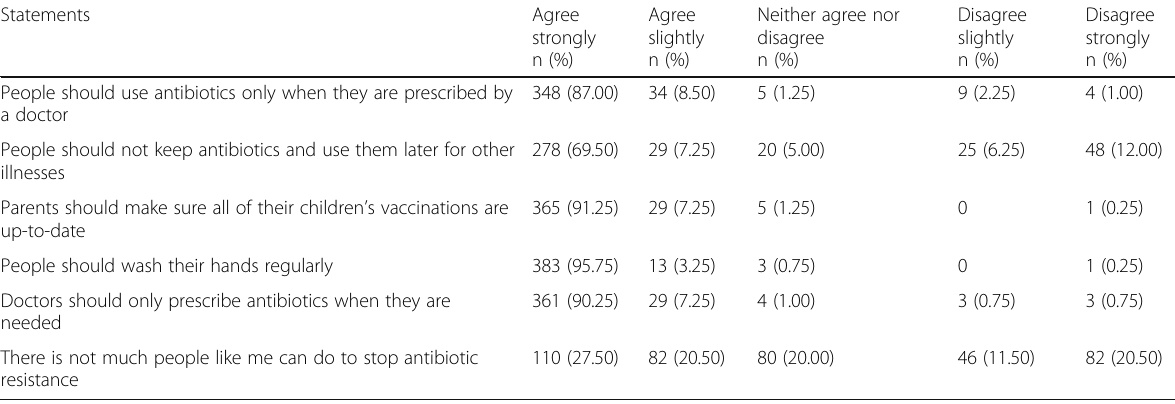
Table 3 Attitudes towards actions to reduce antibiotic resistance (n = 400)